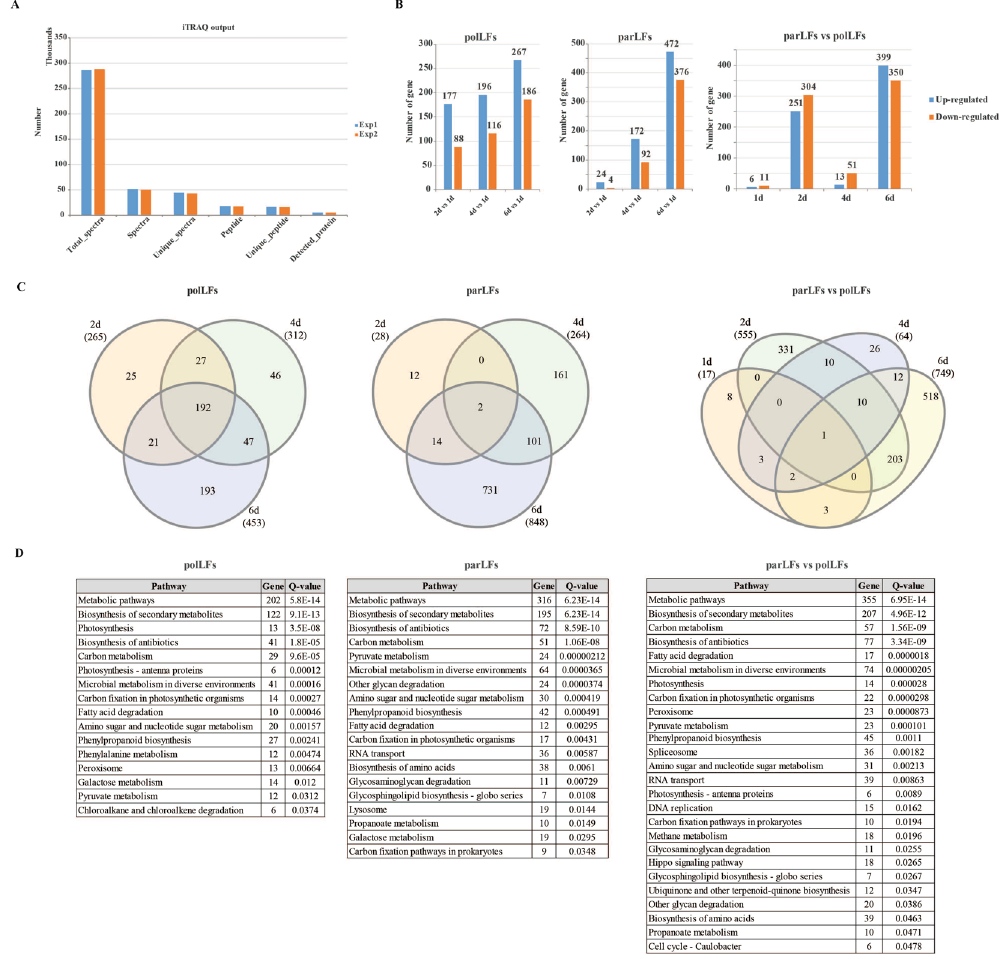
Figure 4. iTRAQ proteomics analysis of polLFs and parLFs. ( A ) Overview features of of two individual iTRAQ experiments. ( B ) Differentially expressed proteins identified. Left: DEPs in polLFs (relative to polLF1d); middle: DEPs in parLFs (relative to parLF1d); right: DEPs in parLFs (relative to polLFs) at different stages. ( C ) Venn diagrams of DEPs. Left: DEPs in polLFs (relative to polLF1d); middle: DEPs in parLFs (relative to parLF1d); right: DEPs in parLFs (relative to polLFs) at different stages. ( D ) Significant ( q < 0.05) KEGG pathways of DEPs identified in polLFs and